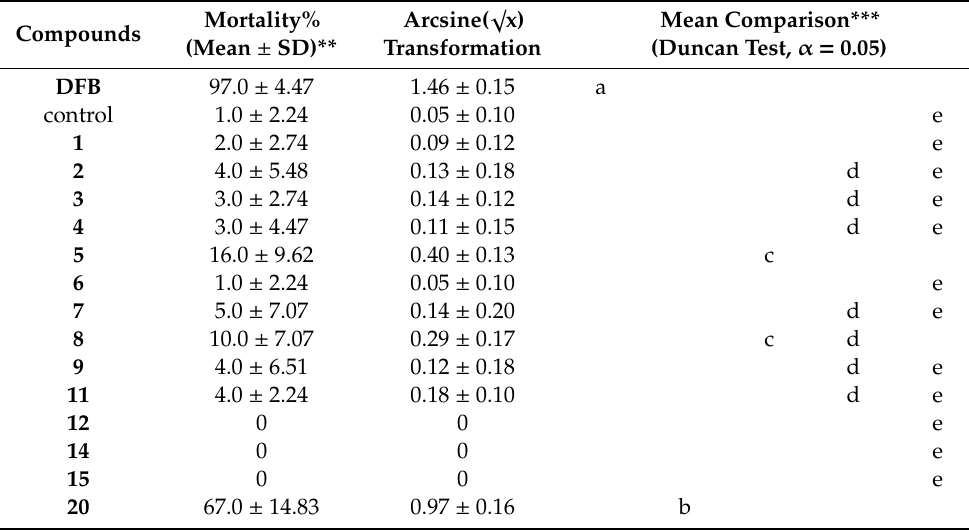
Table 3. Insecticide activity, as percentage of mortality, on mealworm larvae ( Tenebrio molitor ) of fourteen of inhibitors compared with DFB * . Compounds